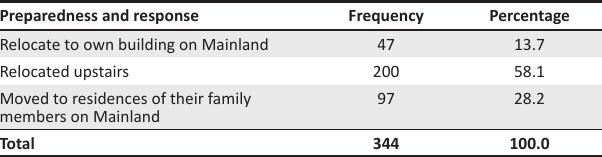
TABLE 6: Recommended densities for residential developments. TABLE 7: Preparedness and response to